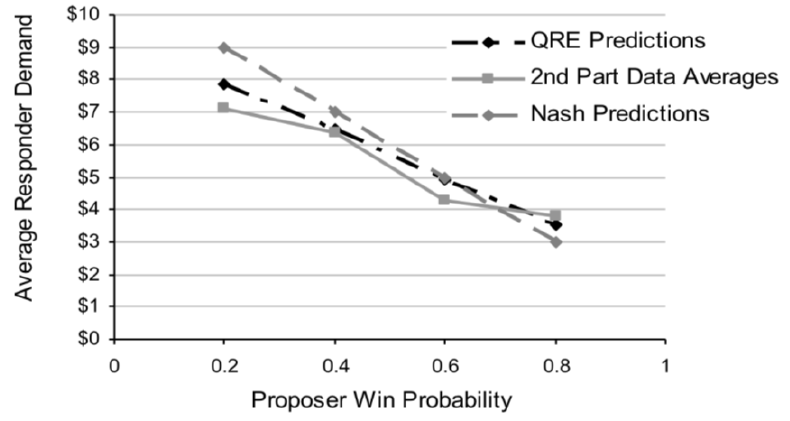
Figure 8. Conflict Rates (Second Part) and QRE